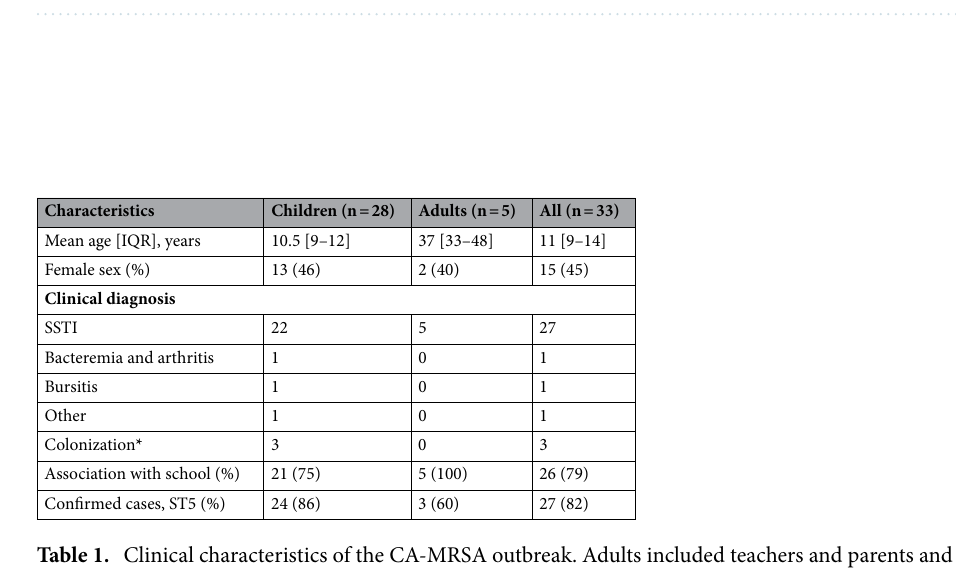
Figure 2. Epidemic curve of confirmed and probable cases with measures initiated during outbreak investigation (n = 33).